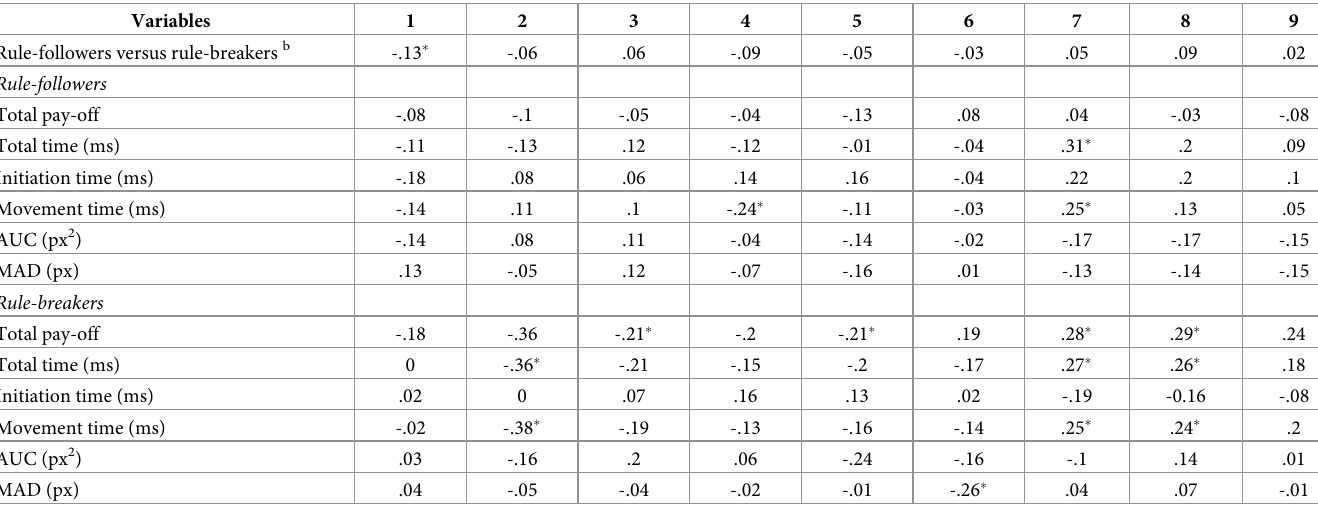
Table 3. Main correlation findings of rule-followers versus rule-breakers and personality, and across individuals in these two groups during the "rule" part.